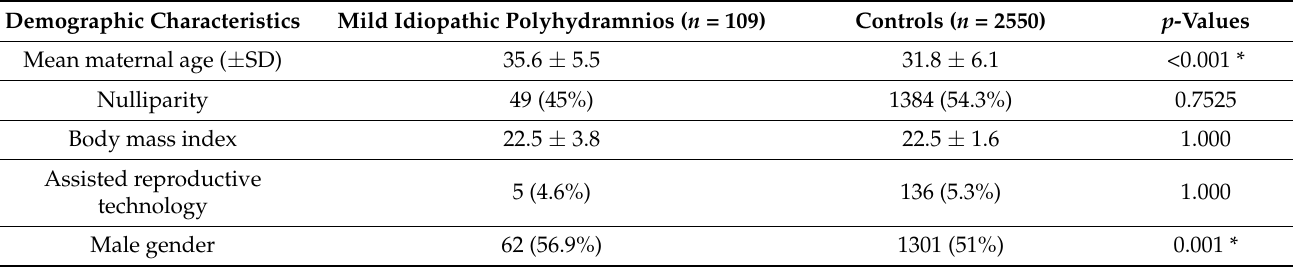
Table 1. Maternal characteristics of the study